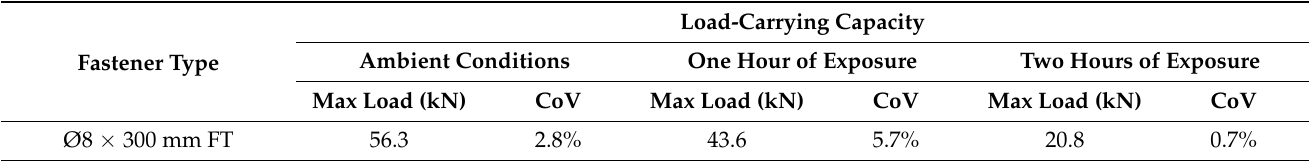
Table 5. Average withdrawal resistance per connection for 4 × Ø8 mm screw at 45 degrees in accordingly presuming a charring rate of 0.7 mm/min under fire conditions.